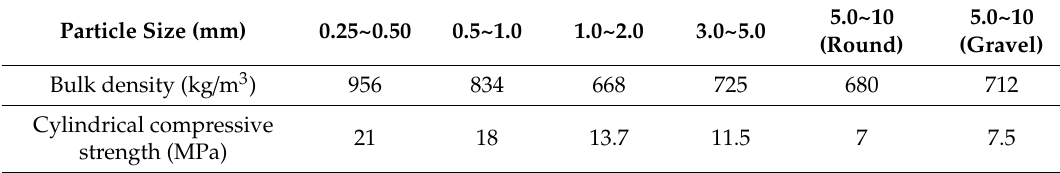
Figure 1. Appearance of coal gangue aggregate: ( a ) coarse coal gangue aggregate; ( b ) fine coal gangue aggregate.